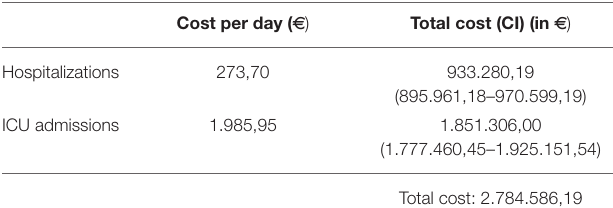
TABLE 6 | Patient hospitalization cost per day, and total cost of estimated positive cases for incoming travelers.